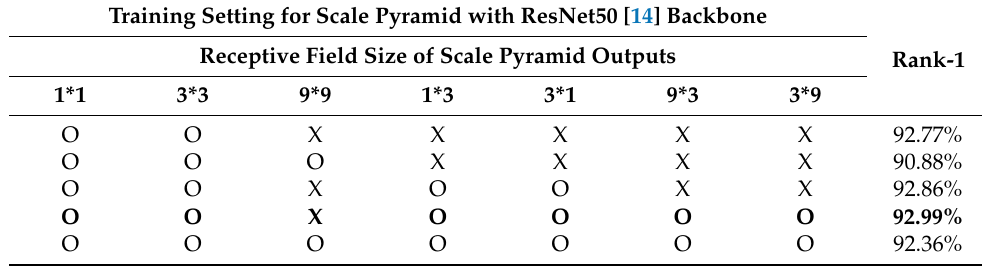
Table 2. Configuration evaluation result for scale pyramid